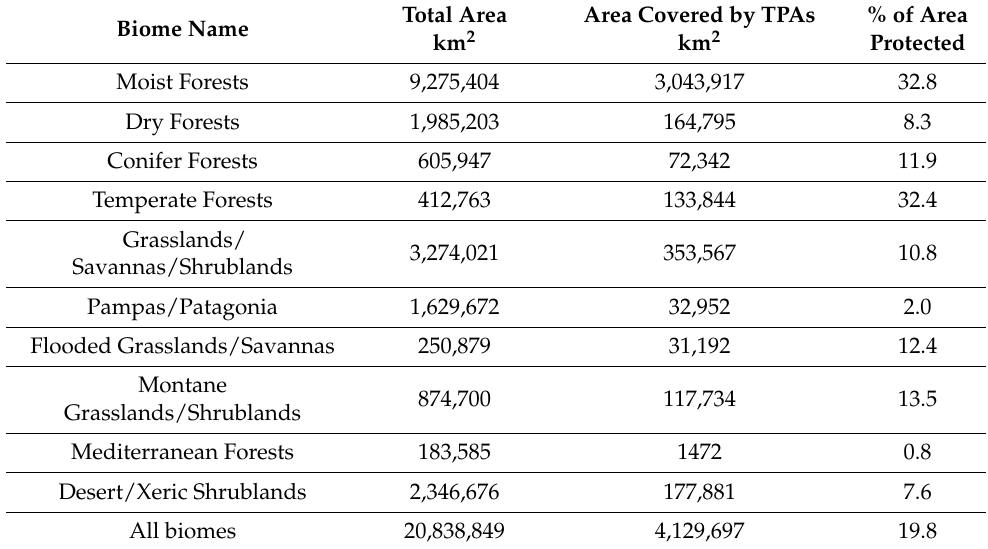
Table 2. The area covered by TPAs by biome in LAC (TPAs are from the WDPA database that included those designated up to the year 2012). Note: the Pampas/Patagonia and Montane Grass- lands/Shrublands are not included in analyses of woody cover change.